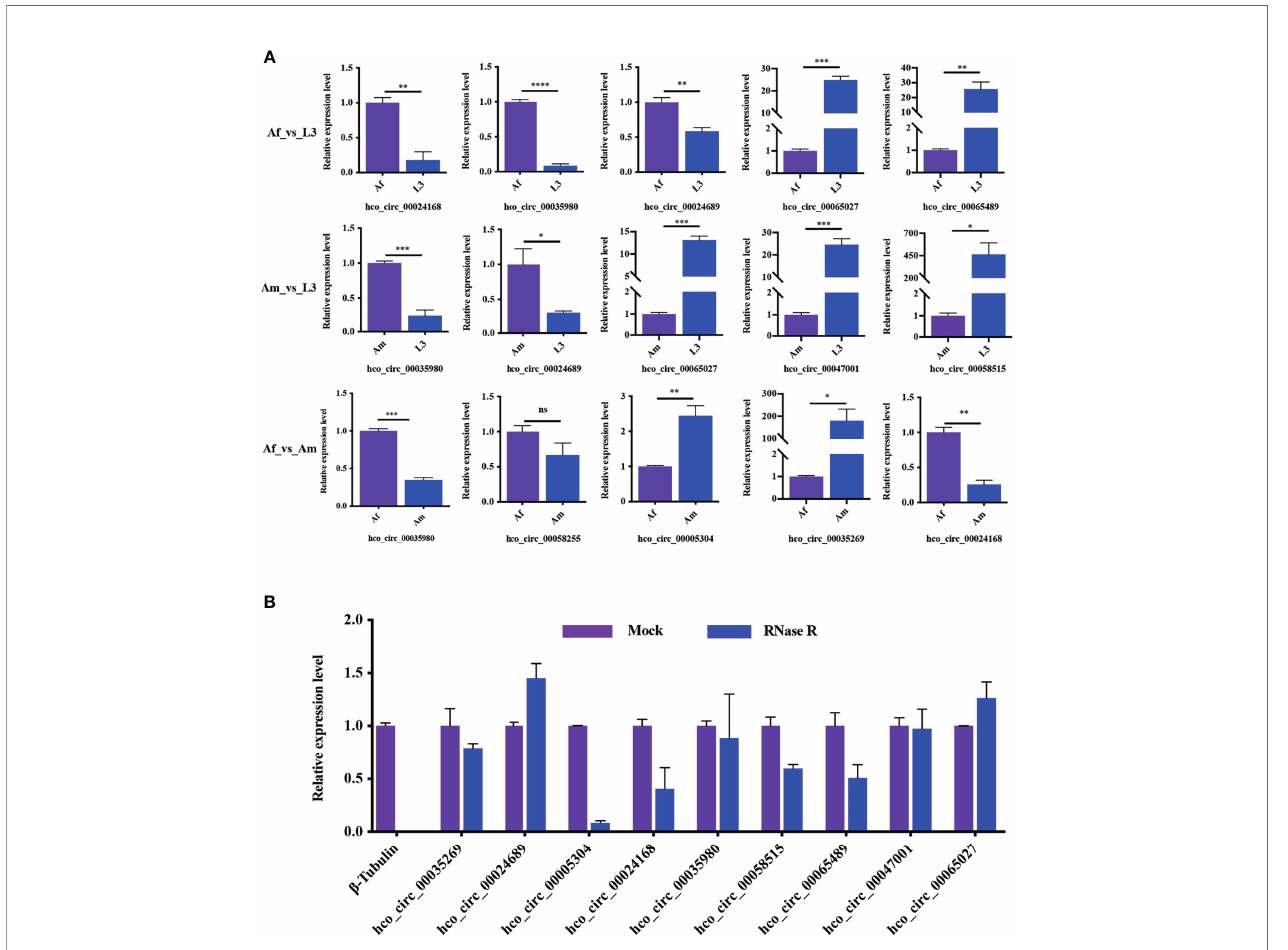
FIGURE 6 | Reliability veri fi cation of RNA-Seq and the resistance of circRNAs to RNase R digestion. (A) The validation of differentially expressed circRNAs in all three comparisons. All experiments were conducted in three independent biological replicates and presented as means ± SEM. The expression levels among different groups were compared by Student ’ s t-test. *P < 0.05; **P < 0.01; ***P < 0.001, ****P < 0.0001. ns, no signi fi cant. (B) The results indicated that circRNAs were detected in both RNase R treated and control RNA samples, whereas the linear control b -tubulin gene wasn ’ t detected in RNase R treated sample. All experiments were conducted in two independent biological replicates and presented as means ±